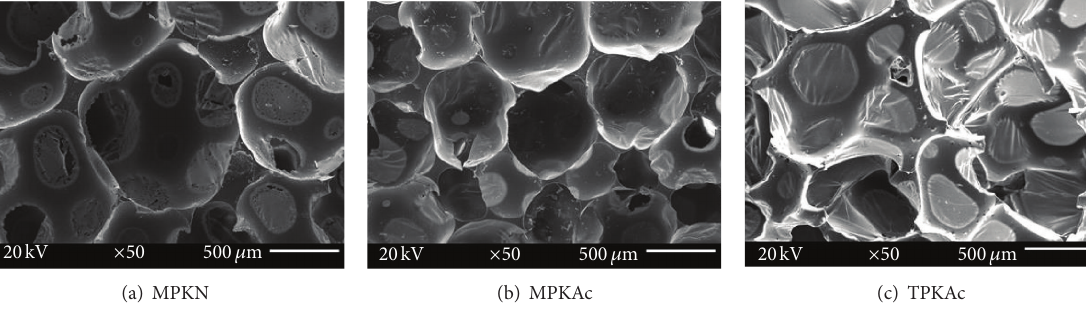
Figure 4: SEM images of PU-keratin membranes after the removal